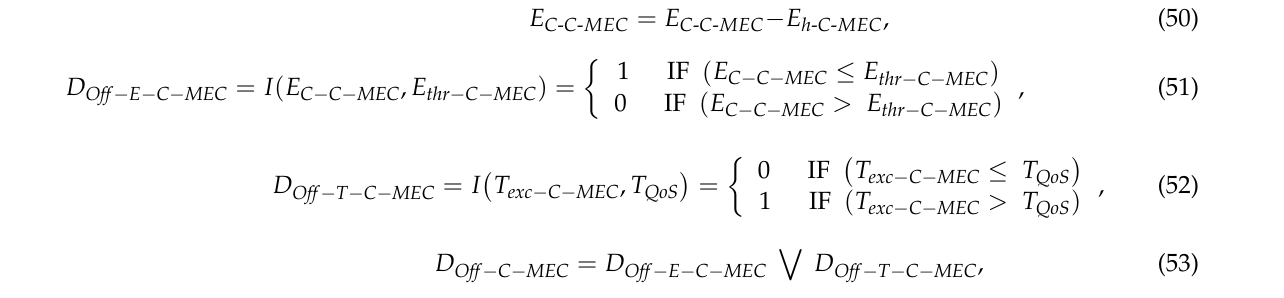
Algorithm 3 Latency-aware and energy-aware offloading algorithm for mobile edge